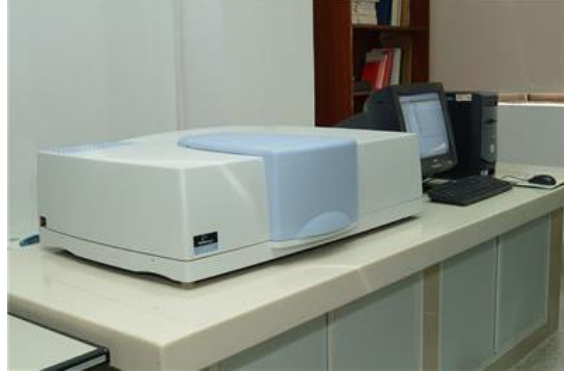
Figure 6. Lambda 950 UV/VIS Spectrometer.